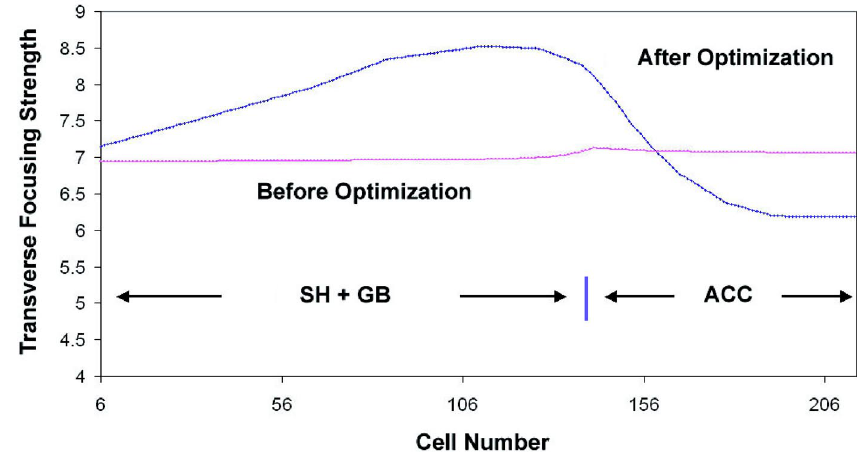
FIG. 2. (Color) Variation of the transverse focusing strength along the PKU deuteron